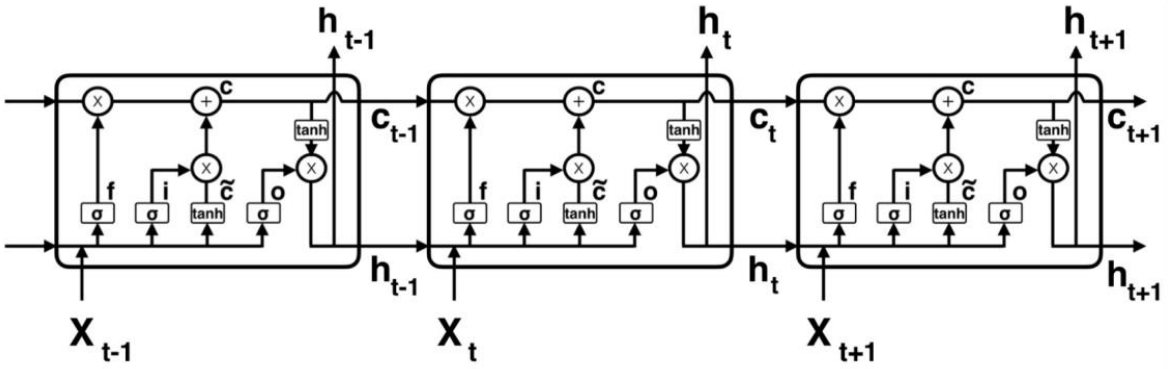
Figure 7. Illustration of an LSTM.